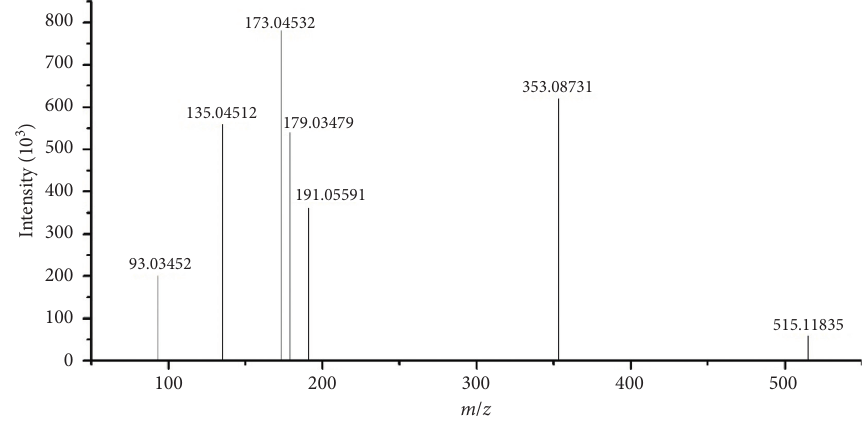
Figure 5: MS 2 spectrum of compound